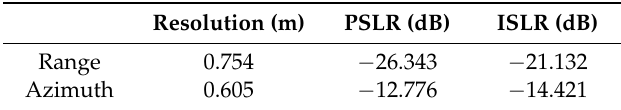
Figure 7. The compression result of the corner reflector processed by the two-step processing algorithm. ( a ) The compression result of the corner reflector in slant range; ( b ) The compression result of the corner reflector in azimuth; ( c ) The two-dimension contour in azimuth and slant range. Table 5. The performance of compression just processed by two-step algorithm.